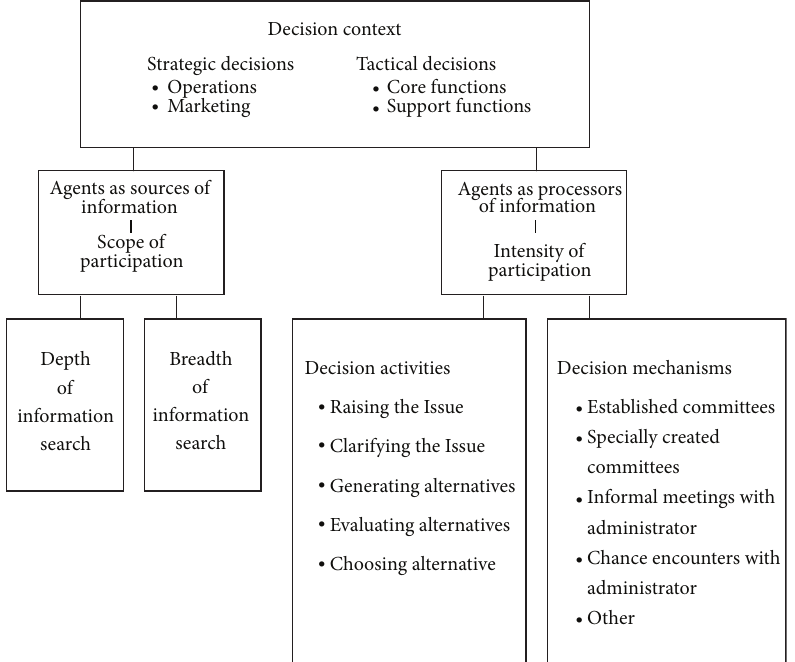
Figure 1: Components of the participation in decision-making instrument. Participation in decision making has two major dimensions, Scope and Intensity. Scope is comprised of breadth and depth of information brought by participants. Intensity is comprised of decision activities and mechanisms through which decision participants process information. Decision making takes place within the context of the decisions to be made, which for organizational decision making are categorized as strategic (operations or marketing) and tactical (core functions and support